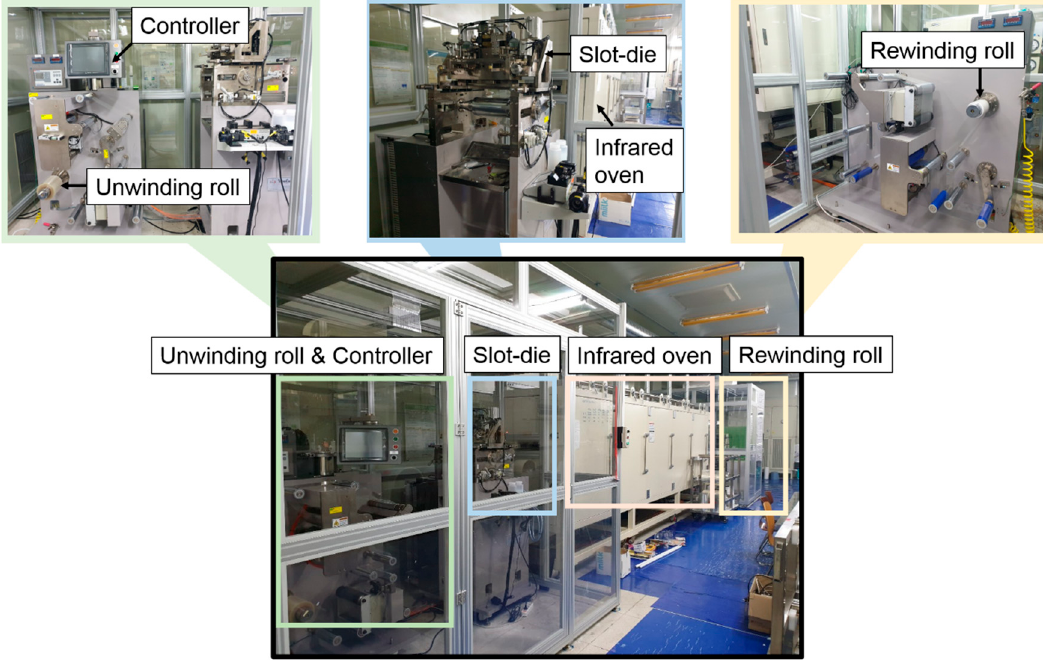
Table 1. Materials and fabrication processes for the air-gap touch sensors.